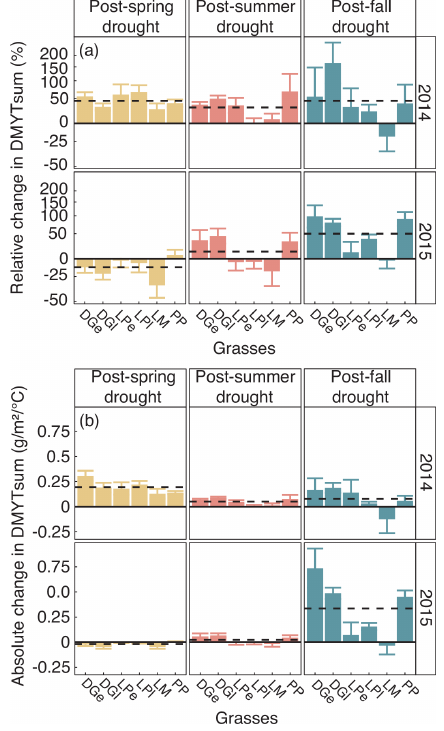
Figure 7. (a) Relative (RCG) and (b) absolute (ACG) changes in temperature-weighted growth rates (DMYT sum ) for the second post-drought growth period (weeks 6 to 10) in 2014 and 2015 af- ter the respective drought (drt) treatment for the individual grasses. Values shown are the means of four replicates ( n = 4; ± SE). Post- drought growth period of the fall drought treatment is the first growth period of the following year. See Fig. 4 for additional ex- planations. The corresponding statistical analyses are shown in Ta- ble A1 in the Appendix.